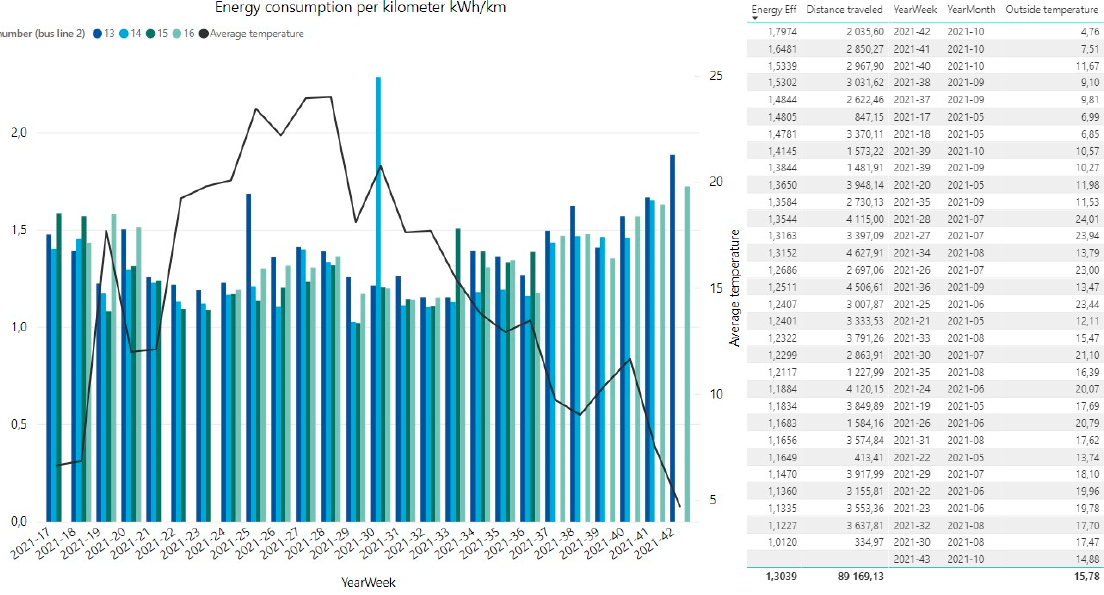
Figure 6. Energy efficiency and outside temperature per week during 1 May 2021–31 October 2021. Disclaimer: The comma is used as a decimal separator instead of a dot because the version of Power BI used in the visualization followed the grammar rules of the Finnish language.